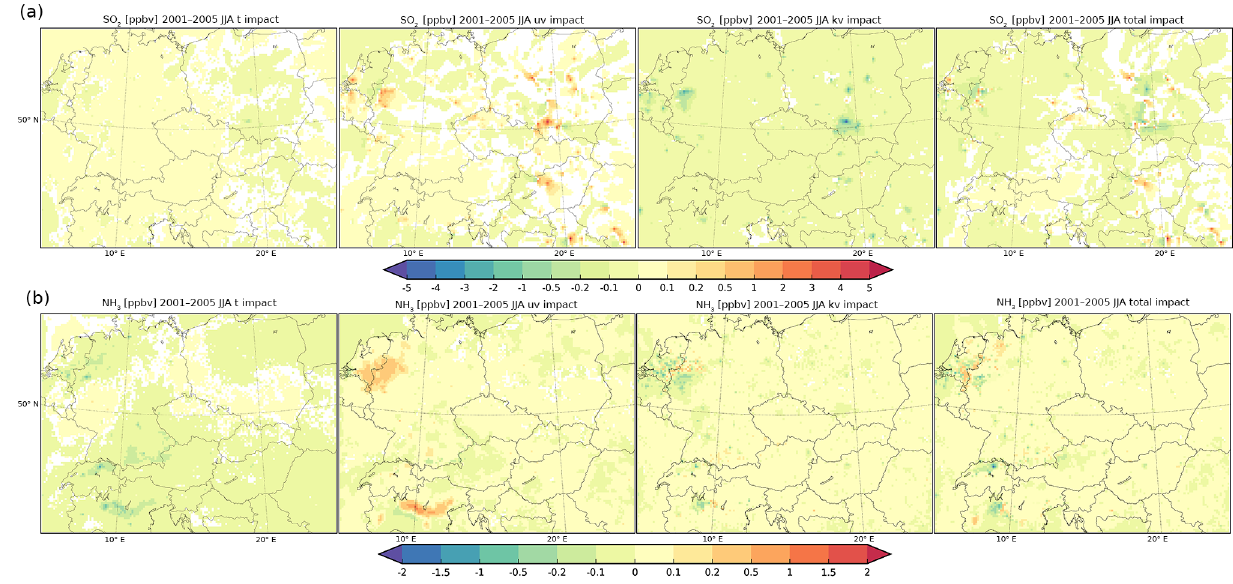
Figure 10. Same as Fig. 9 but for SO 2 (a) and NH 3 (b) in